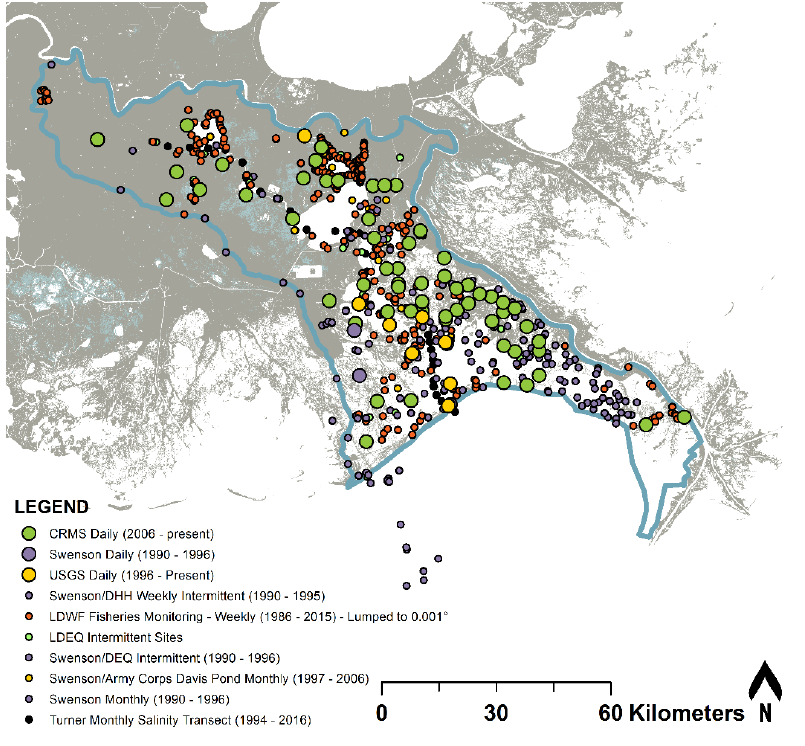
Figure 2. Location of all salinity monitoring data used in this analysis. Dot size on the map is proportional to data collection frequency; the larger the dot, the more frequent the